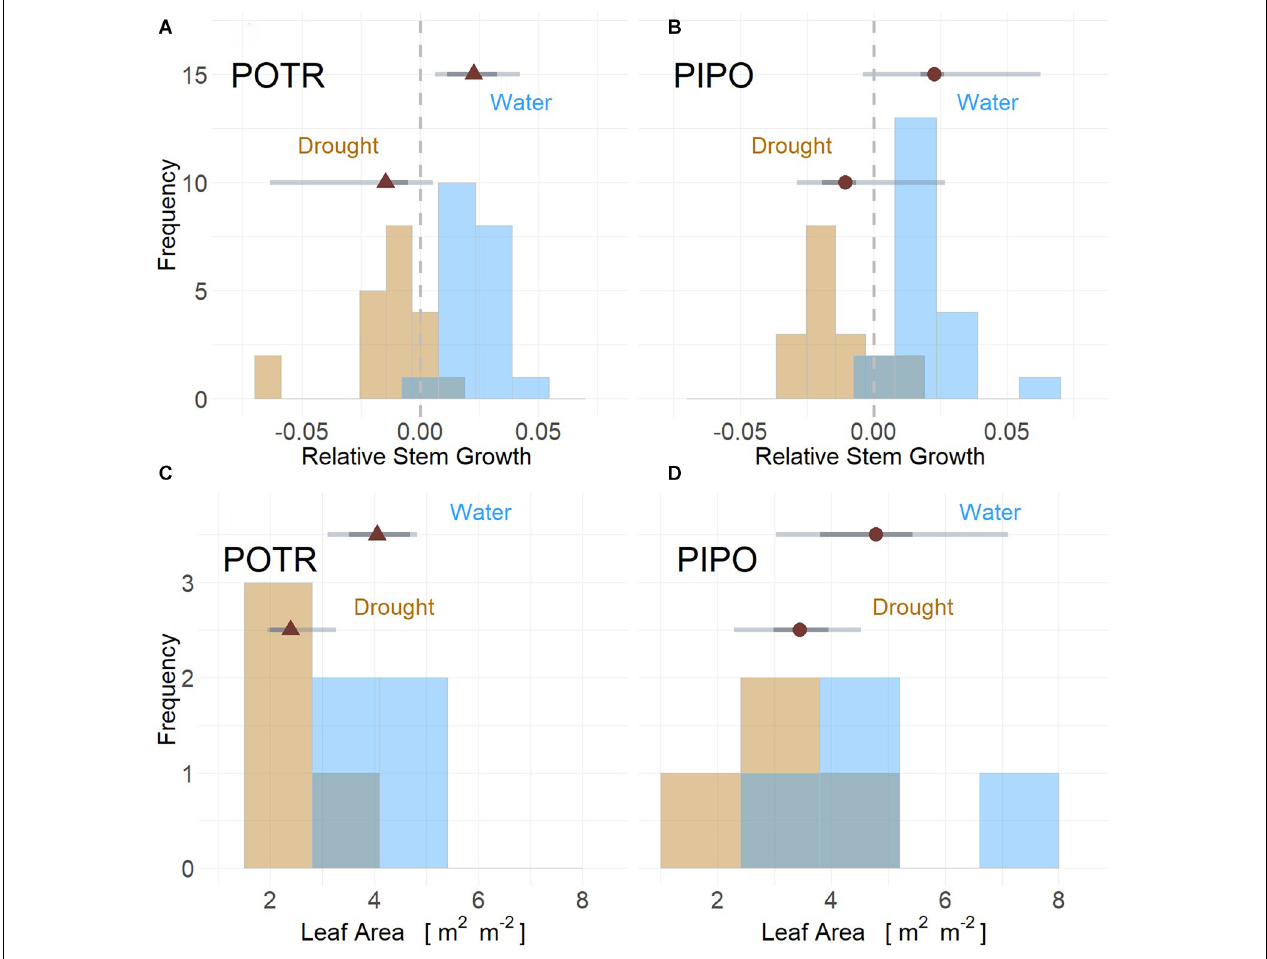
FIGURE 4 | Stem growth and leaf area for POTR (triangle) (A,C) and PIPO (circle) (B,D) under drought (gold) and well-watered (blue) conditions. Stem growth rates from both moderate and severe drought scenarios resulted in limited growth and reductions when compared to well-watered individuals for both POTR (A) and PIPO (B) . Leaf area for both droughted POTR (C) and PIPO (D) were less than well-watered treatments (C) , albeit significant reductions only observed in aspens. Maximum likelihood estimates (MLE, red) with the 50% (dark gray) and 94% (light gray) represented by error